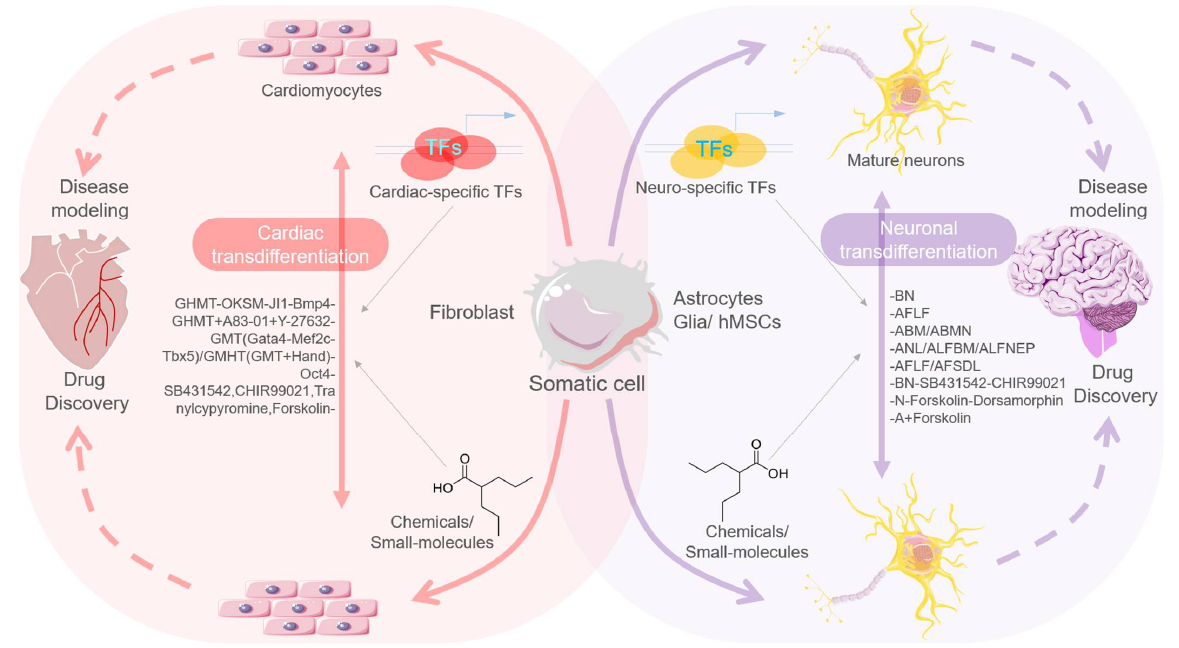
Figure 2. Schematic diagram showing processes of cardiac and neuronal transdifferentiation from a normal somatic cell. Transdifferentiation of somatic cell/fibroblast into cardiomyocytes is induced by certain combinations (listed) of cardiac- specific TFs or chemicals/small molecules ( left side ); while transdifferentiation of somatic cells, specifically of astrocytes, glia, or human mesenchymal stem cells (hMSCs), into mature neurons can be induced by certain combinations (listed) of cardiac-specific TFs or chemicals/small molecules ( right side ). Both processes highlight translational and regenerative potential of transdifferentiation in disease modeling and drug discovery.